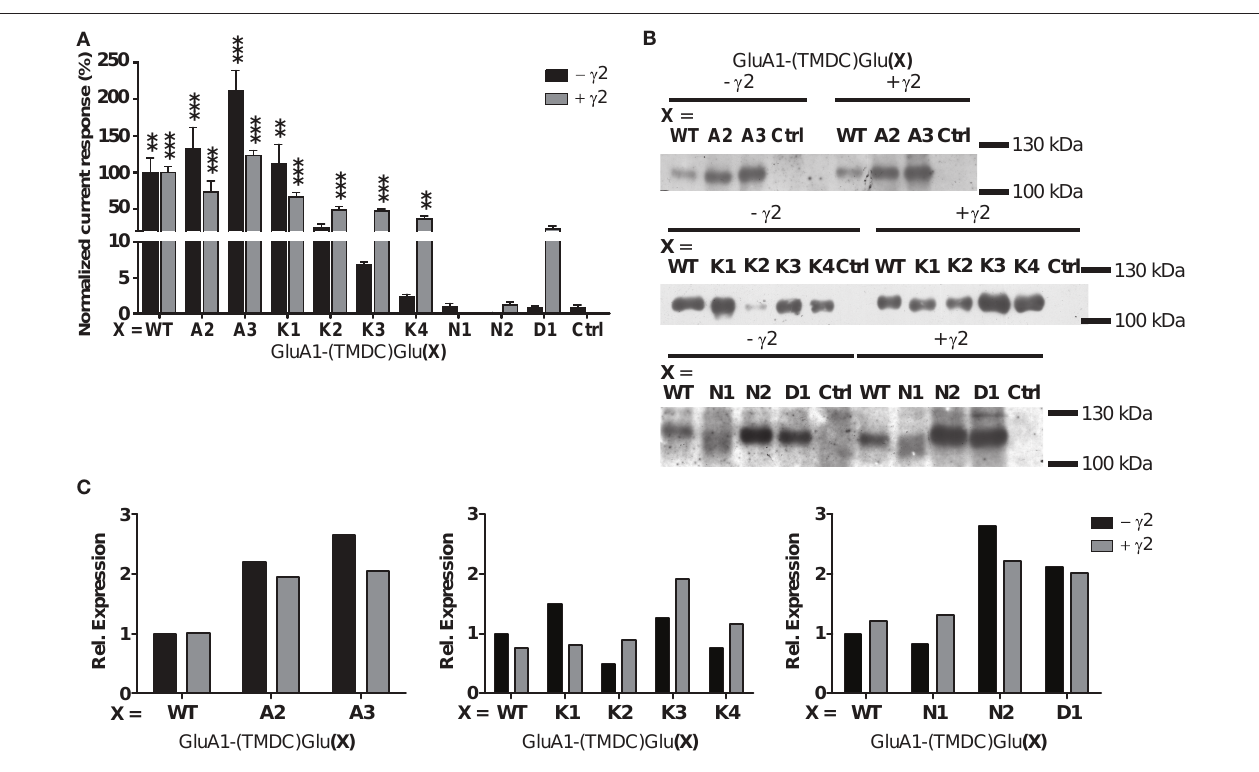
membrane fraction, independently of TARP expression. However, GluA1(TMDC) GluK2 is only weakly present in the absence of γ 2, and GluA1(TMDC)GluN1 exhibits band broadening. Ctrl, controls injected with water. (C) Densitometric quantification of the Western blots shown in (B). Since the membrane protein preparations were performed in three different batches of oocytes, band intensities were normalized to GluA1 wild type in absence of γ 2 for each